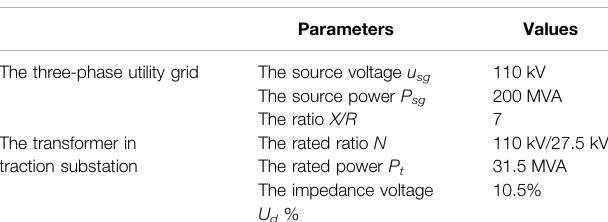
TABLE 2 | The simulation parameters of the